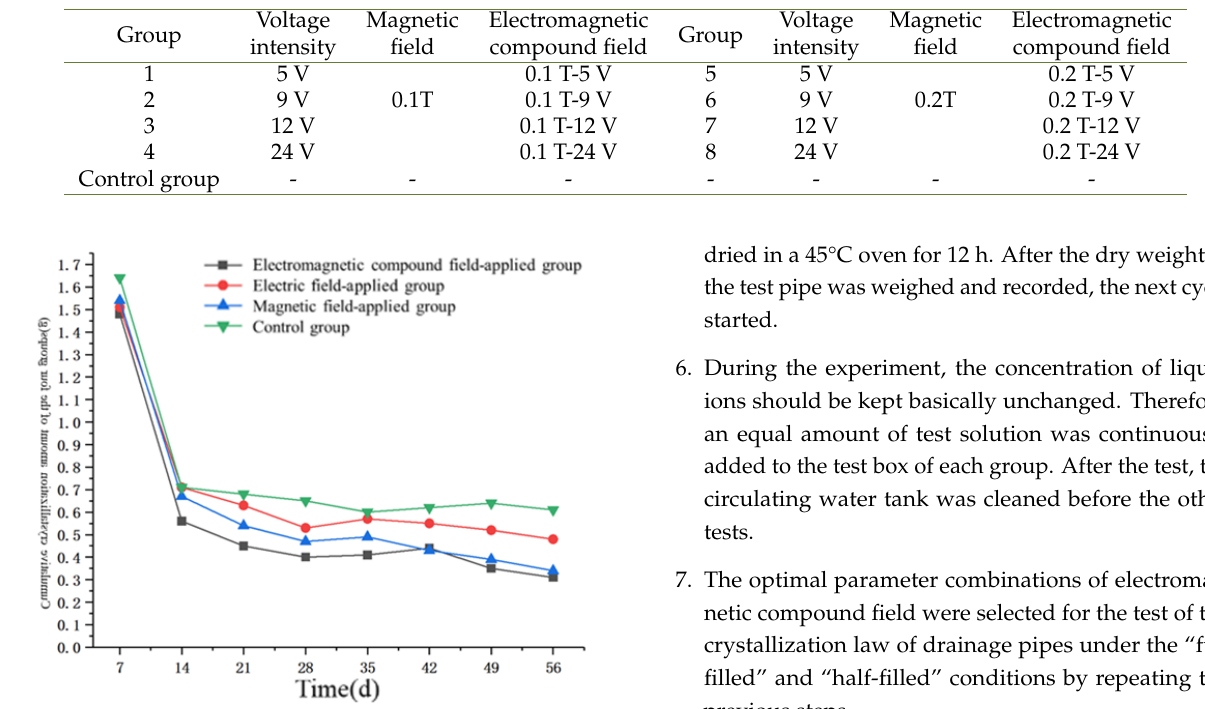
Table 3. Parameter combinations of electromagnetic compound field.